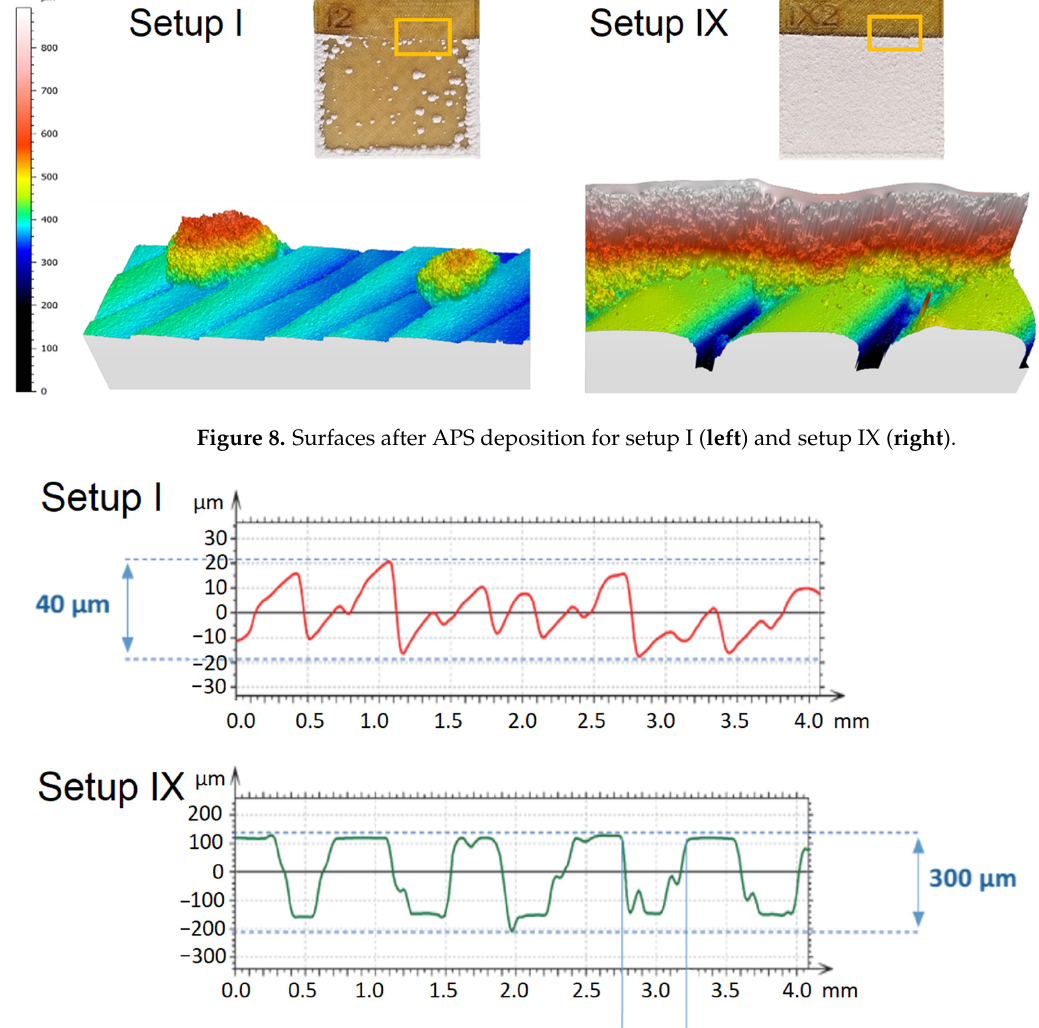
Figure 8. Surfaces after APS deposition for setup I ( left ) and setup IX ( right ).